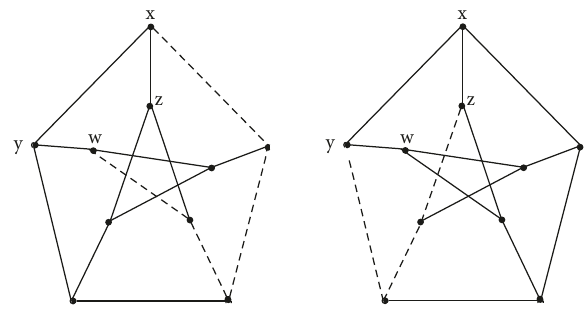
Figure 5: Petersen graph G with sm